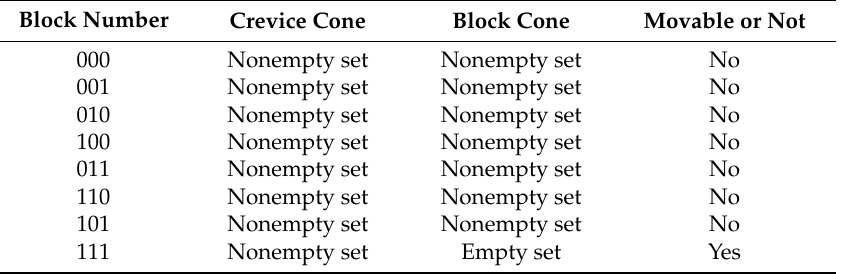
Table 2. Calculation results of movable block of tunnel